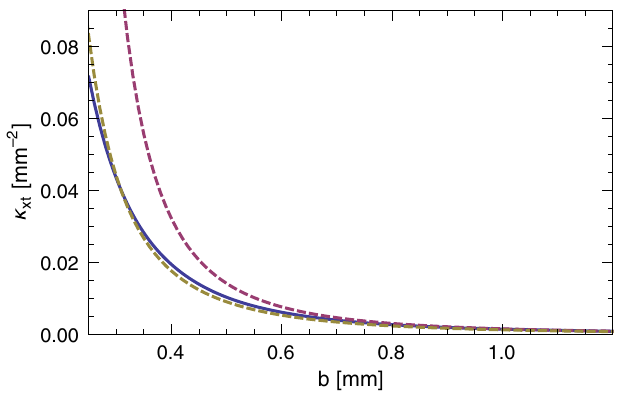
ð b; d Þ as function of beam FIG. 4. The calculated kick factor ϰ xt offset b assuming no tilt in the jaw (blue solid curve). For comparison, the results for tilt parameter d ¼ 0 . 2 mm are given in red dashes; those for tilt parameter d ¼ 0 . 2 mm and shift by offset parameter b 0 ¼ − 70 μ m are given in gold dashes. The corrugation parameters used were those of the RadiaBeam/SLAC dechirper; the bunch distribution assumed was uniform of full length l ¼ 18 μ